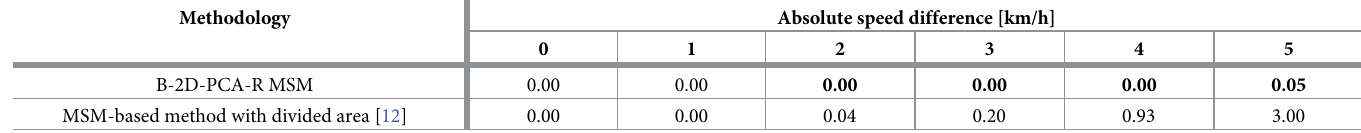
Table 5. Averaged equal error rate (EER) [%] at each absolute speed difference between gallery and probe data for the proposed B-2D-PCA-R MSM and the MSM- based method with divided areas [12].